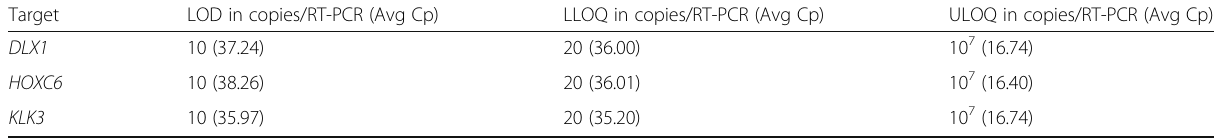
Table 3 The analytical measurement range of the assays for DLX1 , HOXC6 and KLK3